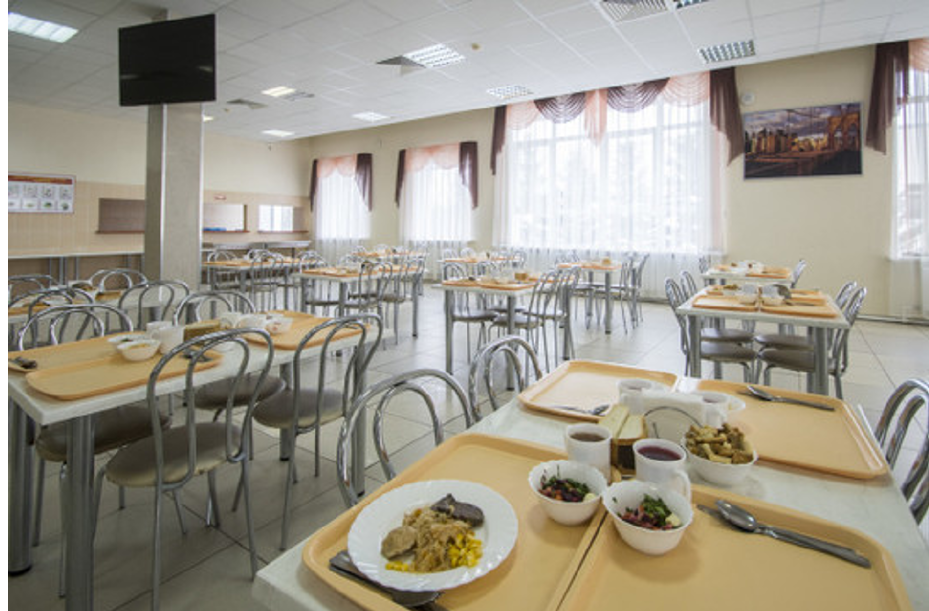
Figure A1. A quarter of Kazan’s educational institutions offer halal meals to children: 131 educational institutions of Kazan, including 38 schools and 93 kindergartens, are provided with halal-cooked meat products (data from the Department of Food and Social Nutrition of the capital of